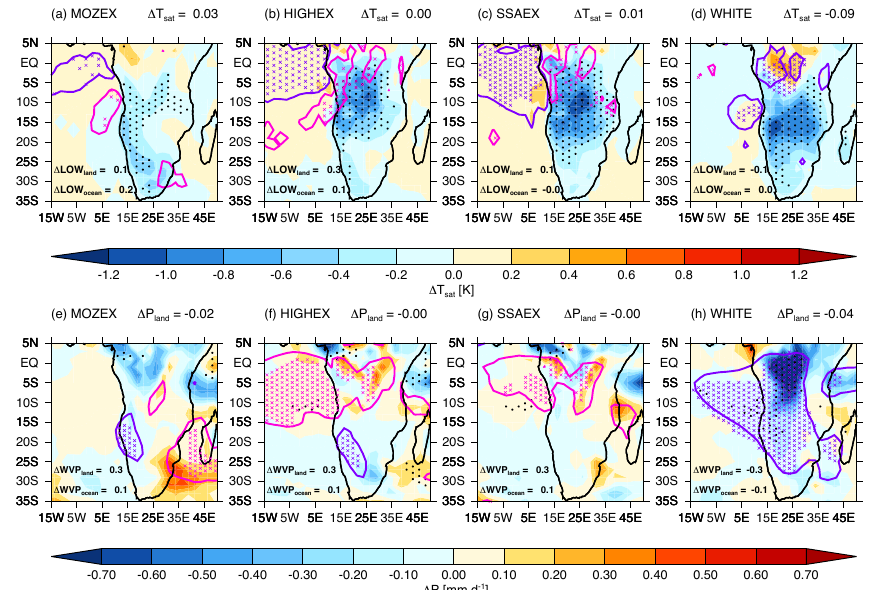
Fig. 6. ASO surface air temperature change relative to CTRL ( 1T sat ; [K]) (shaded) for (a) MOZEX, (b) HIGHEX, (c) SSAEX, and (d) WHITE with black stippling indicating that changes are significant above 90%. Overlain pink (purple) contours are increased (decreased) low-level cloud above (below) 2.5% with pink (purple) crosses denoting 90% significance. Change in total precipitation relative to CTRL ( 1P ; [mmd − 1 ]) (shaded) for (e) MOZEX, (f) HIGHEX, (g) SSAEX, and (h) WHITE with black stippling indicating 90% significance. Overlain pink (purple) contours are increased (decreased) column-integrated precipitable water ( 1 WVP) above (below) 0.5mm with pink (purple) crosses denoting 90%